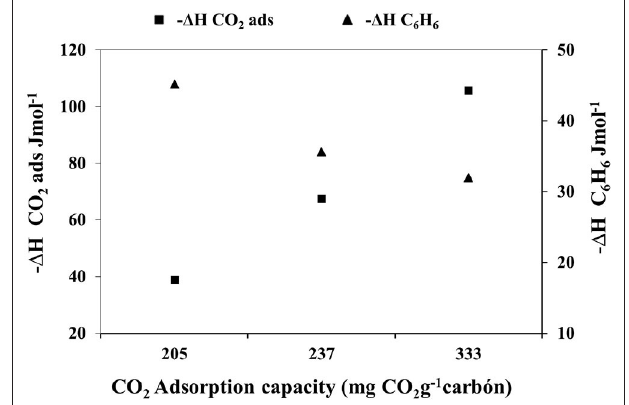
FIGURE 7 | Relationship between the CO 2 adsorption capacity of activated carbon, enthalpy of adsorption of CO 2 and enthalpy of immersion in